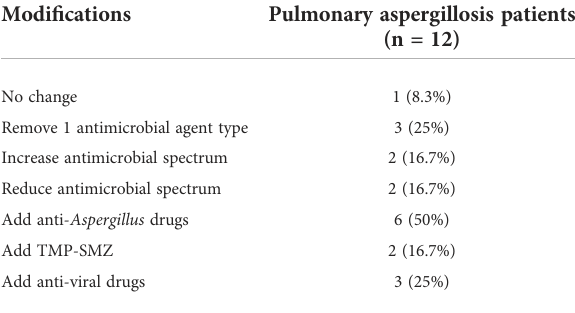
TABLE 3 Impact of mNGS on antimicrobial therapy of pulmonary aspergillosis in non-neutropenic patients. Modi fi